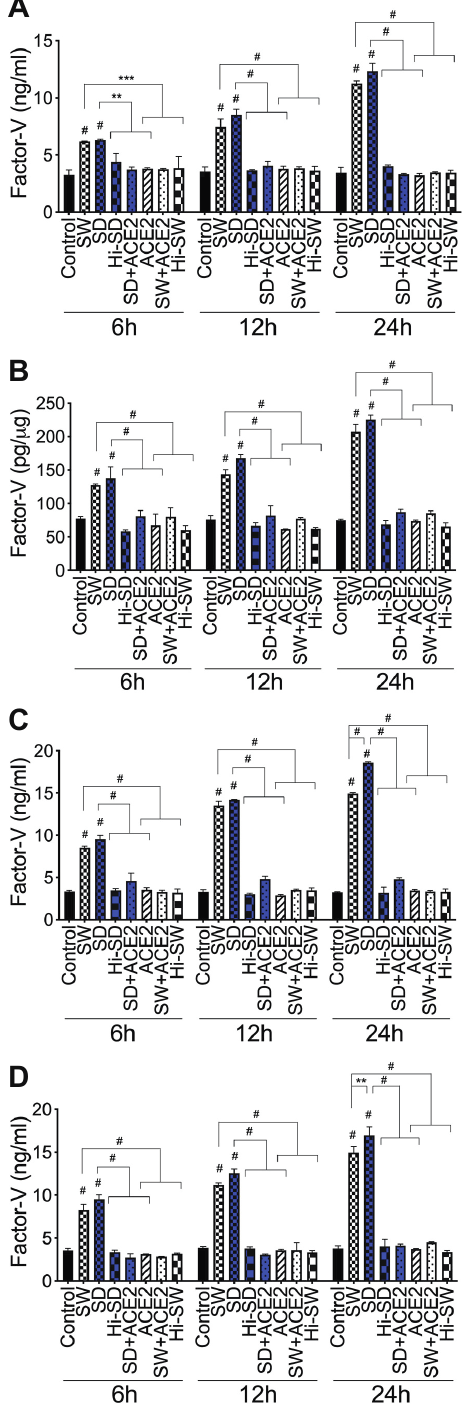
Figure 3. S-proteins and endothelial–neutrophil interactions increase Factor-V expression and release in HLMEC. ( A , B ) HLMEC treated with S-proteins (1 nM SW or SD) for 6–24 h; ( C ) HLMEC treated 6 h with S-proteins, washed, and co-cultured with neutrophils for 6–24 h; ( D ) neutrophils treated 6 h with S-proteins, washed, and co-cultured with HLMEC for 6–24 h. Following treatments, Factor-V levels in culture supernatants ( A , C , D ) and endothelial cell lysates ( B ) were quantified by ELISA. Data presented as mean ± standard deviation. Control: untreated cells; Hi-SW: cells treated with 1 nM heat-inactivated SW; Hi-SD: cells treated with 1nM heat-inactivated SD; ACE2: cells treated with rhACE2 (1 µ g/mL). ** p = 0.002; *** p < 0.0002; # p <